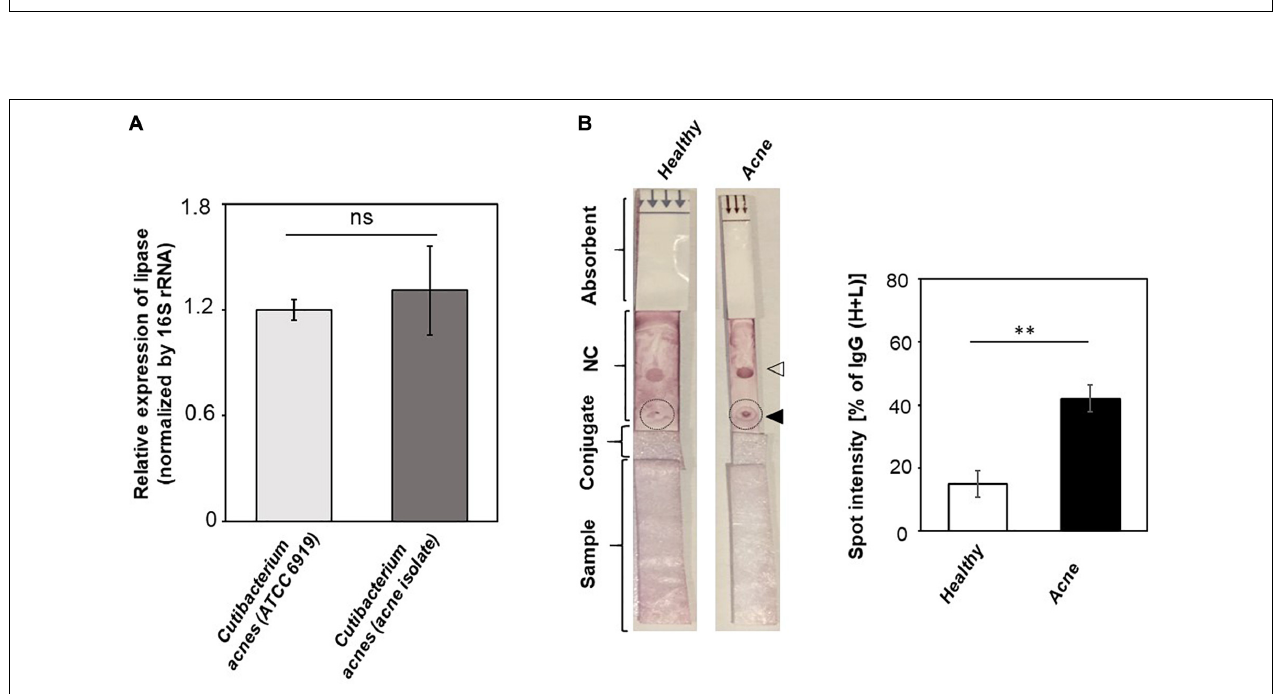
FIGURE 4 | A higher level of antibodies to a C. acnes 74 strain isolated from acne lesions in acne patients as compared to healthy subjects. (A) The expression of the gehA gene encoding lipase in C. acnes ATCC 6919 and a C. acnes 74 strain was detected by RT-qPCR. The relative expression of the gehA gene was normalized to 16S rRNA. Data shown represent the mean ± SD of an experiment performed in triplicate. ns, not significant. (B) LFIAs were spotted with 3 µ g of lysates (solid triangle) of a C. acnes 74 strain and anti–human IgG (H+L) (open triangle). Five percent individual sera (200 µ L) from healthy subjects ( n = 3) and acne patients ( n = 3) were inserted into the sample pads. The relative levels of antibodies (circles) to C. acnes 74 strain were calculated as described in Figure 3 legend. p < 0.01 ( ∗∗ ) with mean ± SD is shown.